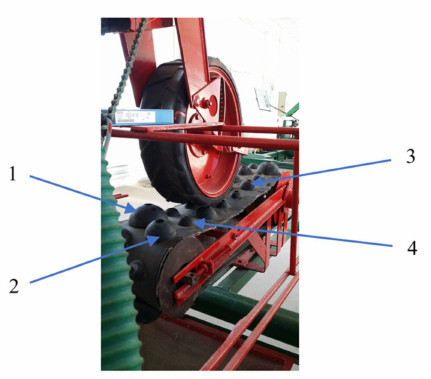
Figure 8. Seed meter drive belt provided with rubber hemispheres: (1) hemispheres with Φ 100 mm; (2) hemispheres with Φ 80 mm; (3) hemispheres with Φ 50 mm; and (4) hemispheres with Φ 30